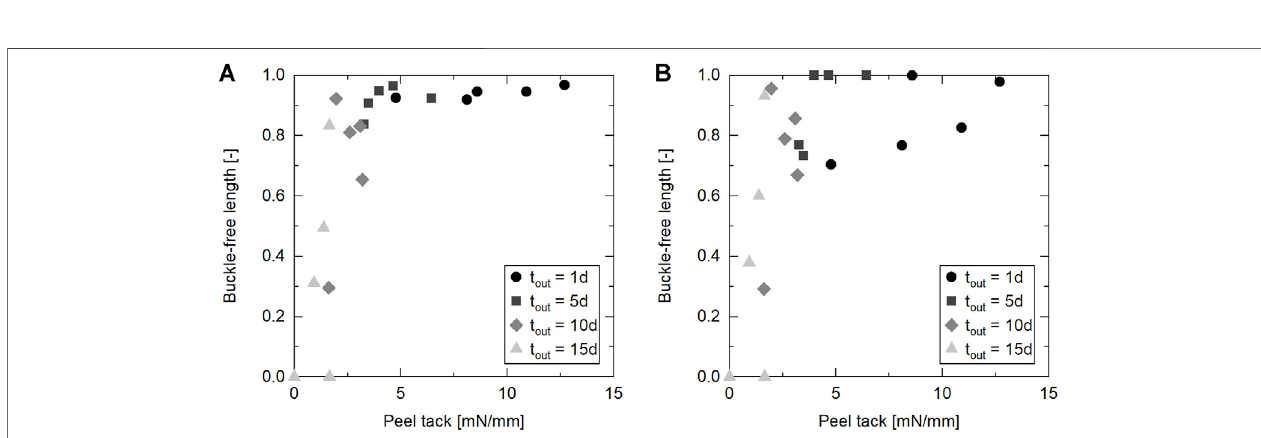
FIGURE 15 | Steering induced defects as a function of peel tack of uncured IM7/8552. (A) Out-of-plane buckles. (B) Tape pull-up.